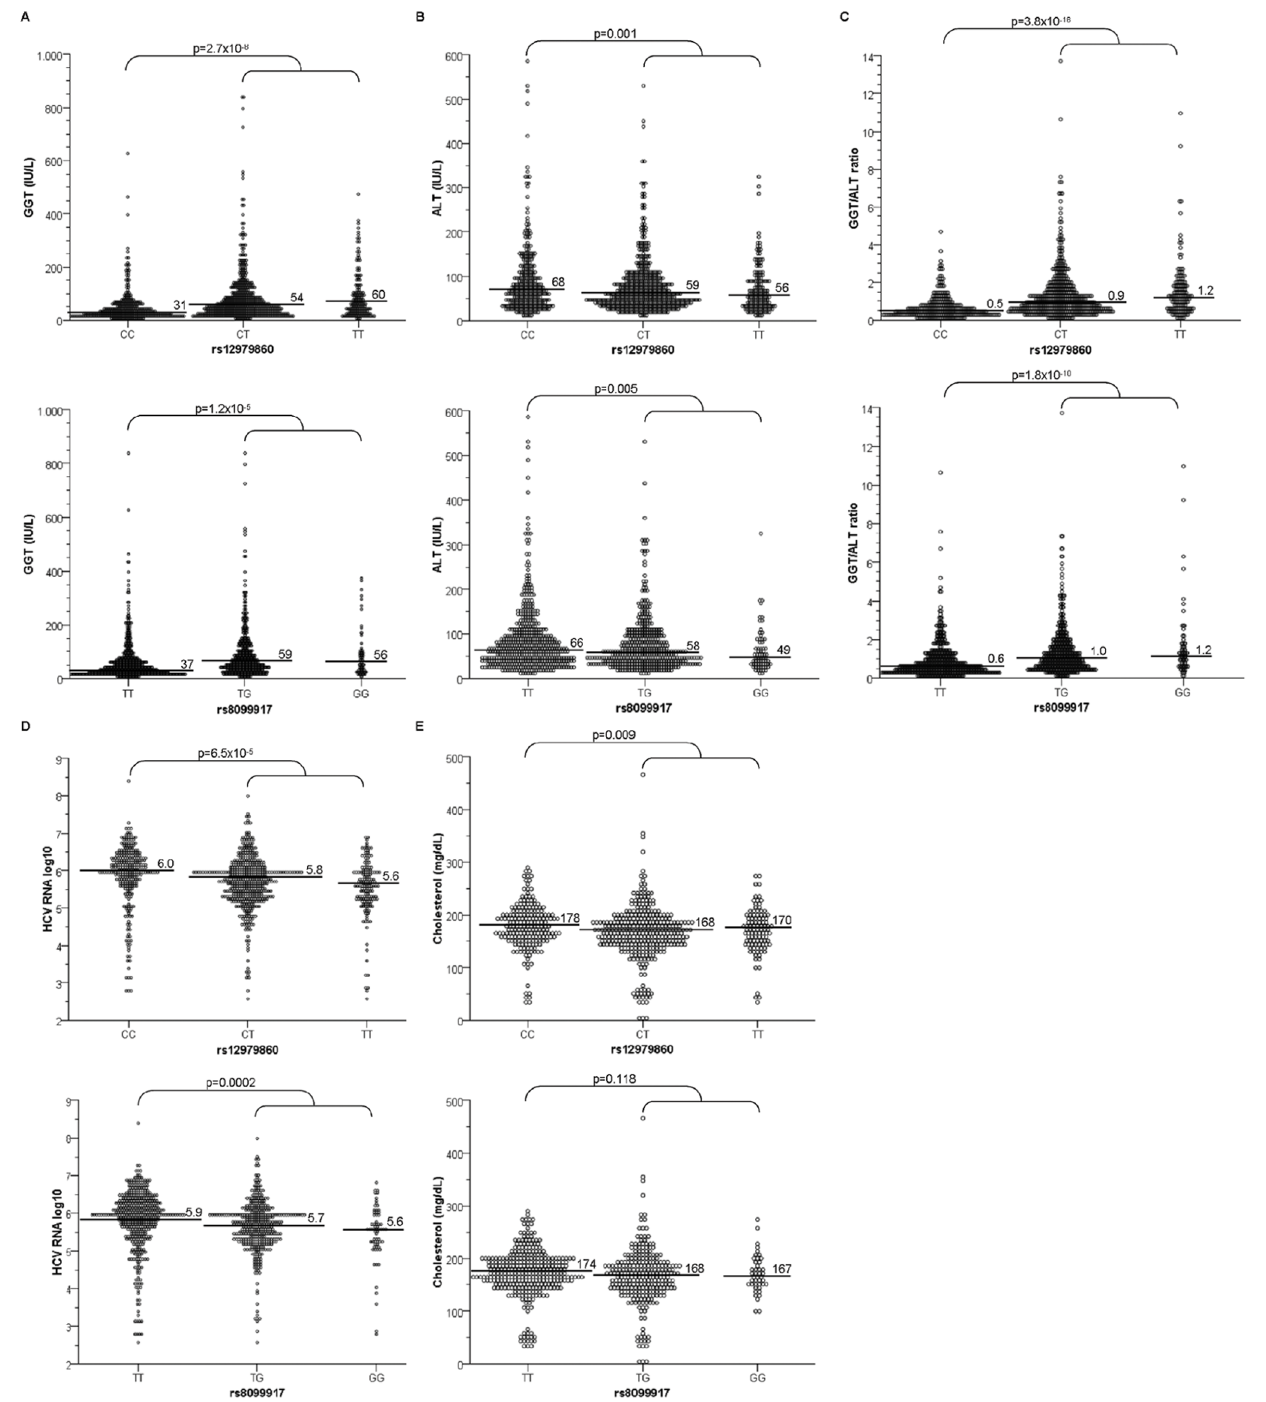
Figure 1. Association of IFNL3 variants with baseline predictors. Association of the IFNL3 rs12979860 and rs8099917 genotypes with the levels of ( A ) GGT (IU/mL), ( B ) ALT (IU/mL), ( C ) GGT/ALT ratio, ( D ) pretreatment HCV RNA log 10 (IU/mL) and ( E ) cholesterol (mg/dL) concentration in the evaluation cohort (EC). Horizontal bars represent the median. Mann-Whitney U-test was used to compare the baseline parameter.